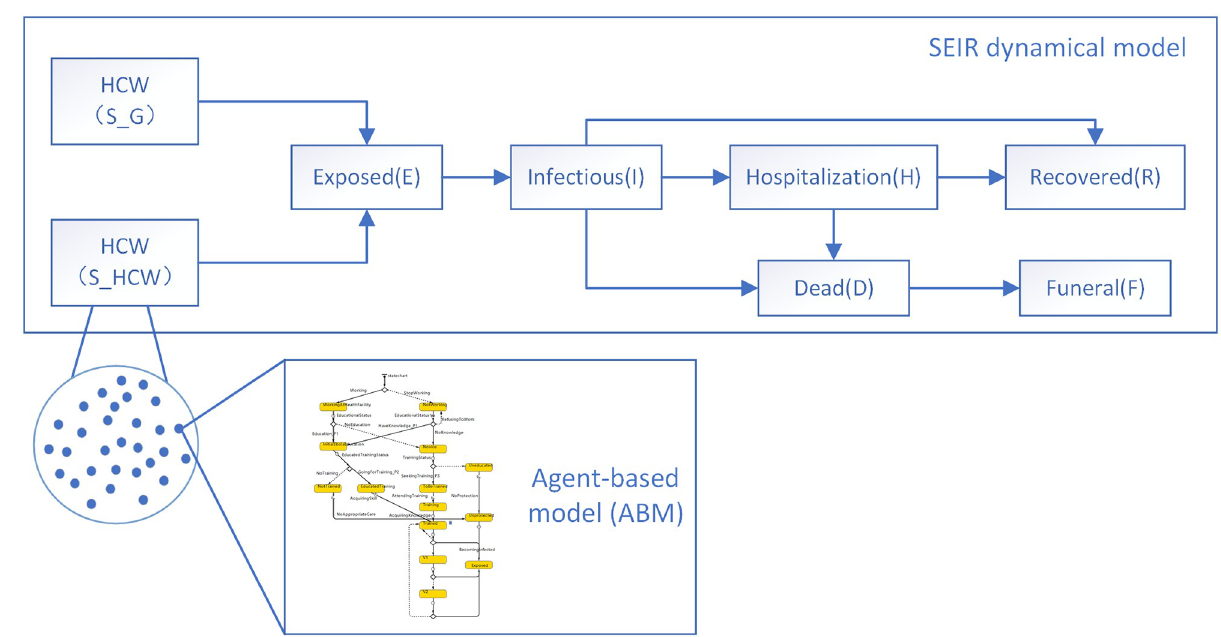
Fig 2. The whole frame of the hybrid model. S HCW means susceptible HCW and S G means susceptible general population. The “susceptible HCW” sub-population acts as linkage between the agent-based modeling and the system dynamics modeling. The state transition diagram shown in the ABM has a detailed description in section “Agent-based